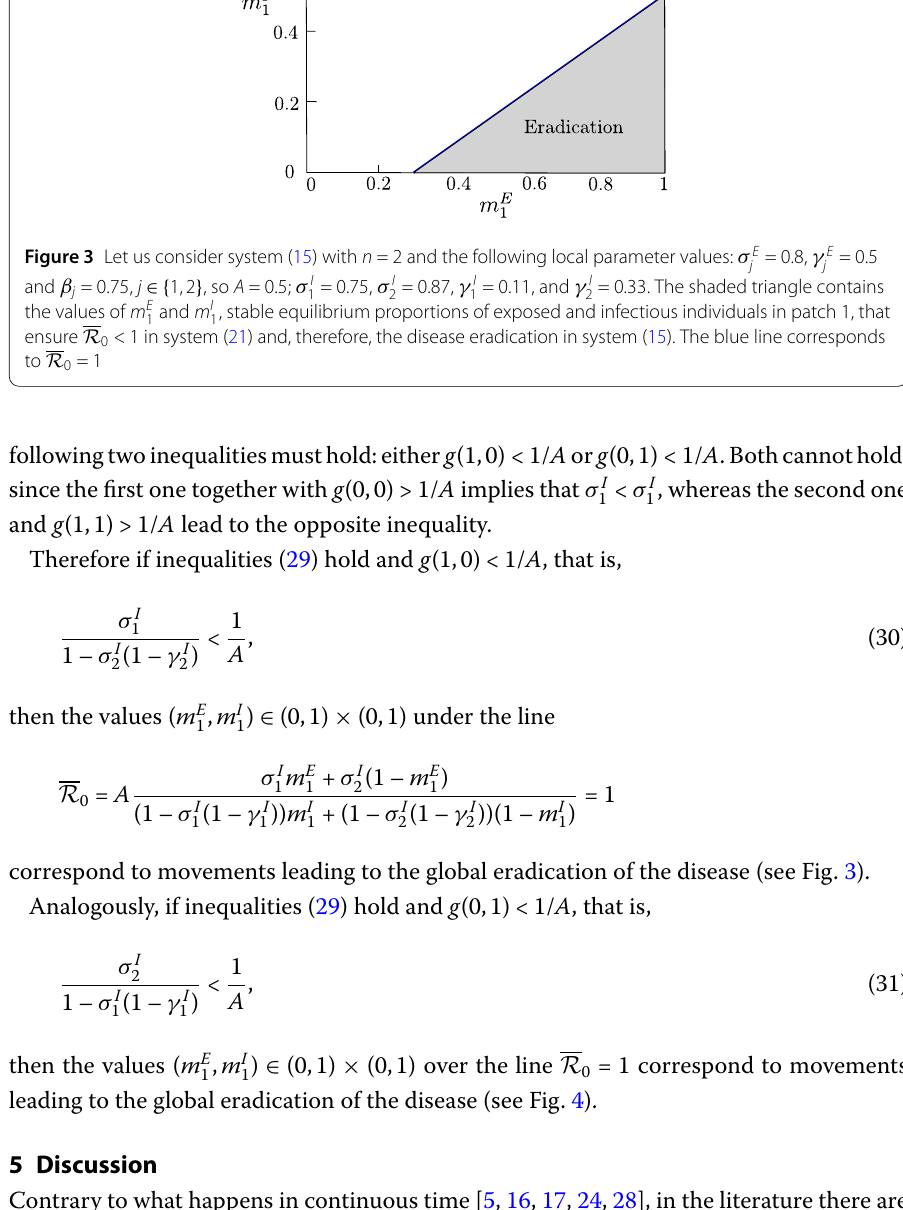
= 0.8, γ E = 0.5 j j